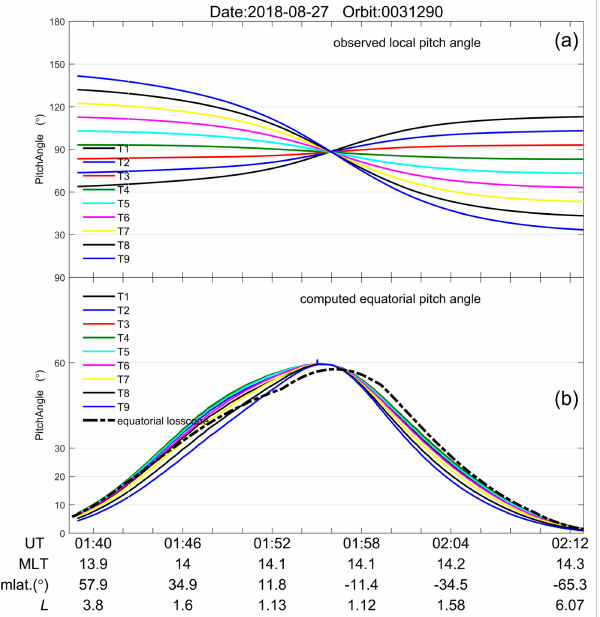
Figure 11. Same as Figure 10 but for orbit No. 0031290 on 27 August